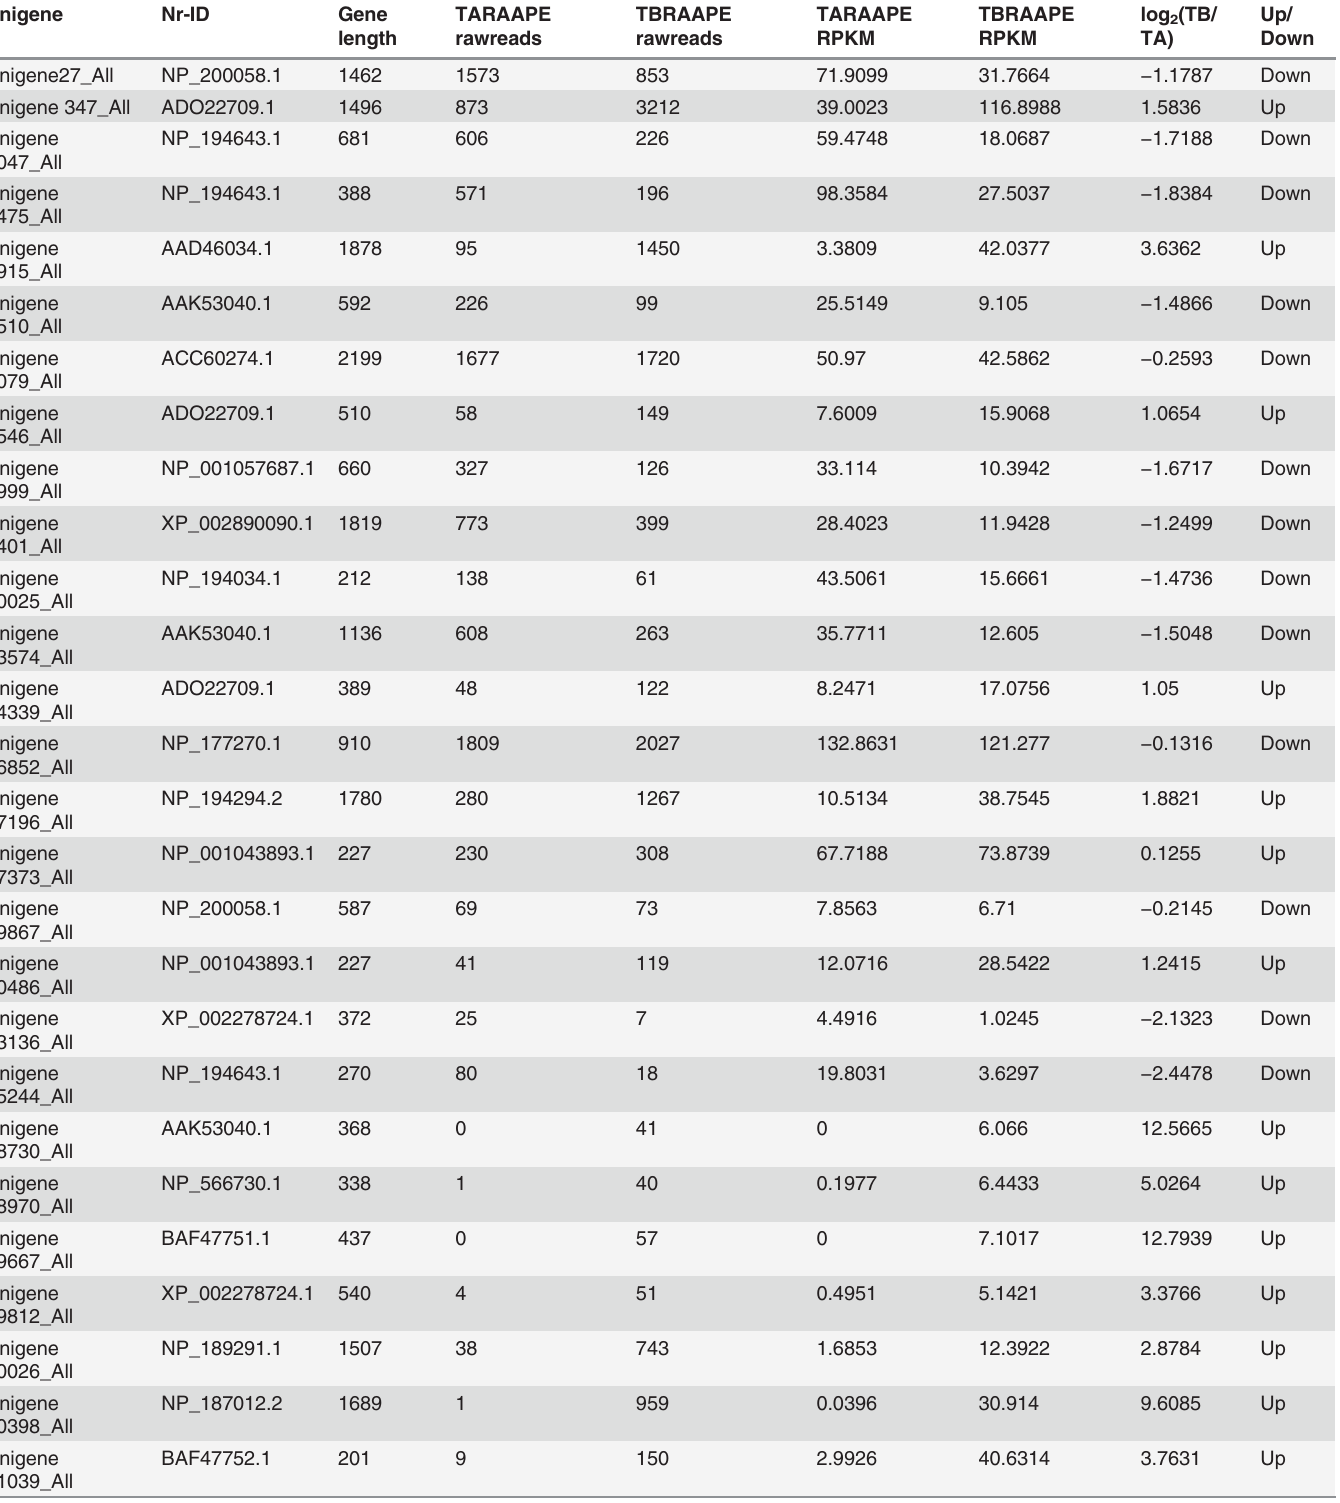
Table 1. Unigenes with a signi fi cant similarity to MATE in the Illumina/Solexa sequencing library of